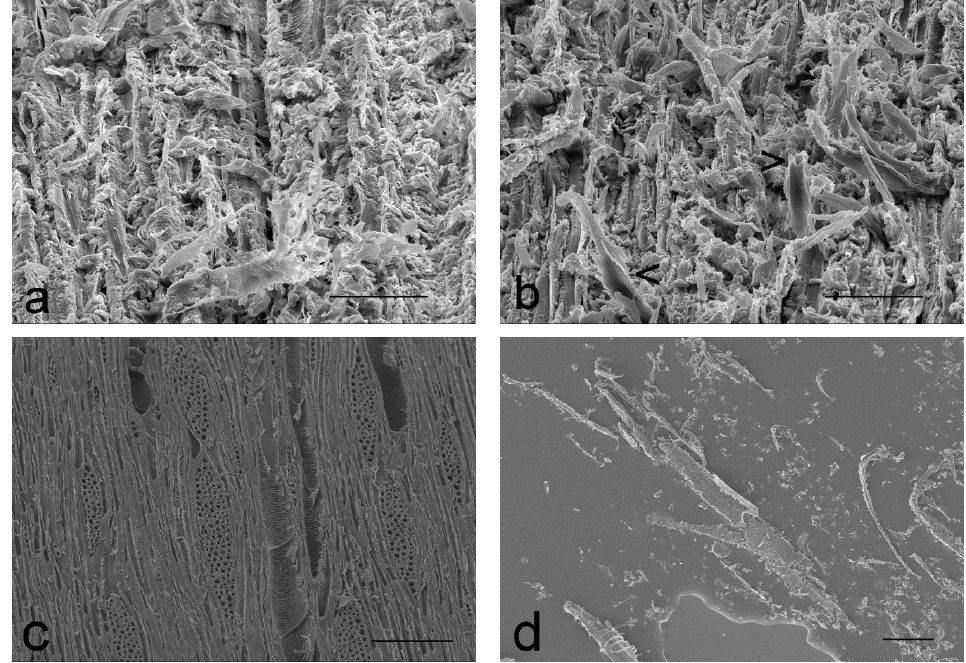
Figure 6. Sugar maple wood surfaces after: ( a ) sanding; ( b ) sanding/wetting/redrying; ( c ) planning/wetting/ redrying; and ( d ) material removed from ( b ) using transparent tape. Scale bars (a,b) = 50 μ m; (c,d) = 100 μ m.